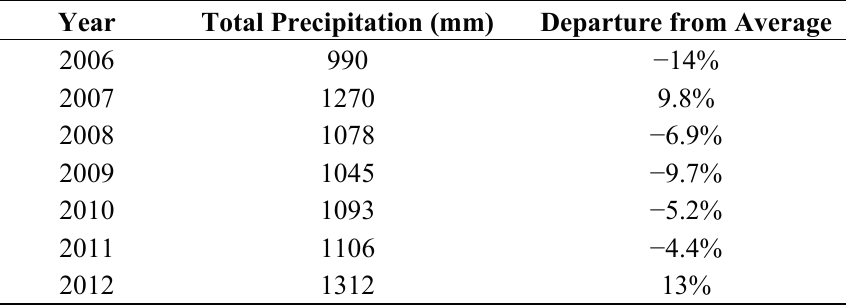
Table 1. Annual precipitation and departure from average.